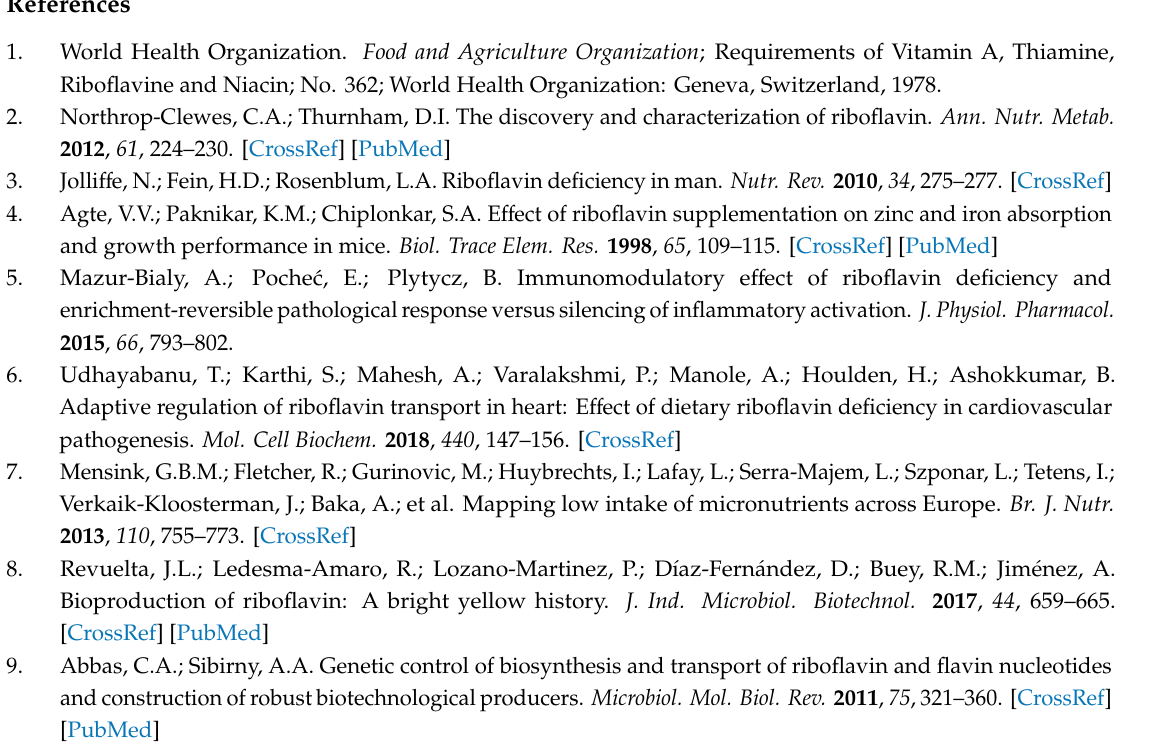
Table S1: The content of riboflavin produced by 90 LAB colonies obtained from CDM plate. Figure S1: (A) PCR products of the riboflavin biosynthetic genes of RYG-YYG-9049 strain. (B) PCR products of the riboflavin biosynthetic genes of RYG-YYG-9049-M10